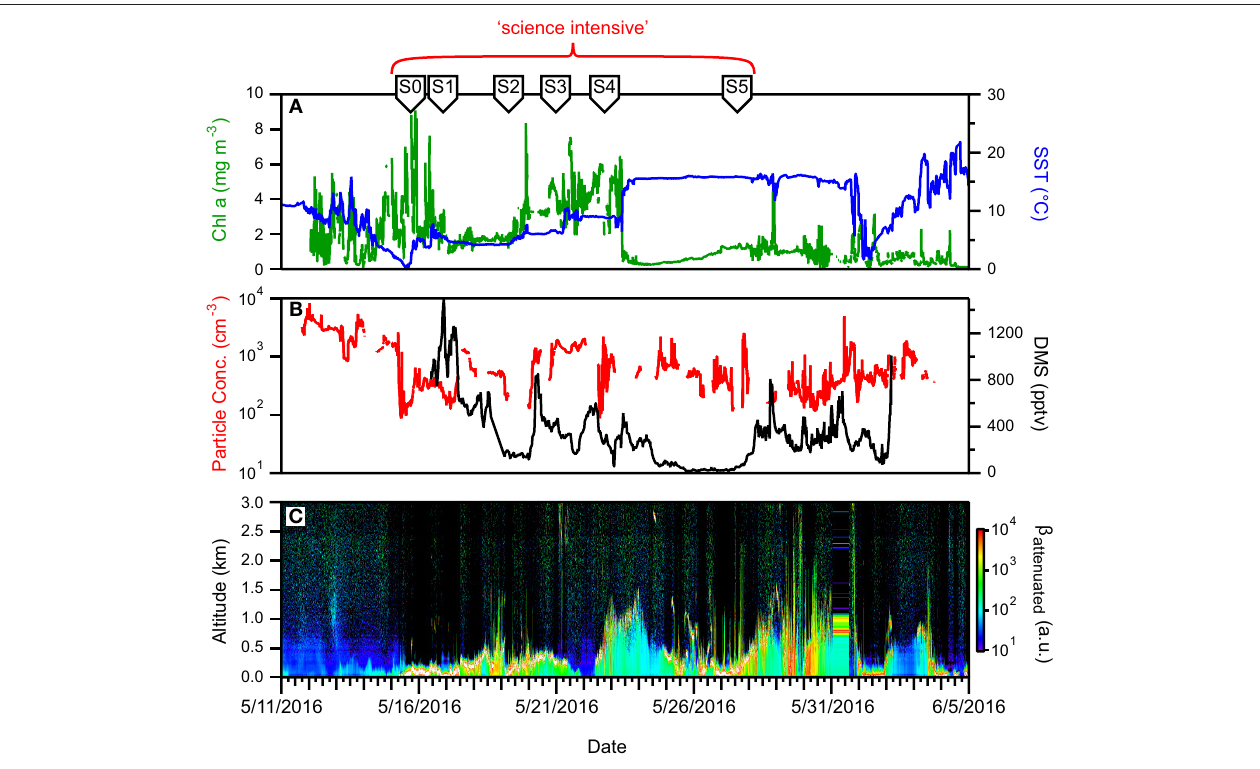
FIGURE 9 | Ocean and atmosphere properties as a function of campaign date during NAAMES 2. (A) Surface chlorophyll concentration (green line) and sea surface temperature (SST; blue line) as a function of hours along ship transit. (B) Particle number concentration (red line) and dimethylsulfide gas mixing ratio (black line) along the ship transit. (C) Attenuated backscatter curtain in arbitrary units as detected by the ship-based ceilometer along the ship transit. The record begins on 5/11/2016 at 40 ◦ 31 ′ N, 70 ◦ 17 ′ W on the outbound transit and ends on 6/5/2016 at 41 ◦ 29 ′ N, 70 ◦ 41 ′ W on the return transit. Red bracket = “science intensive” segment of transit. Labeled symbols at top of panel indicate ship location at the beginning of each primary station (S0–S5).